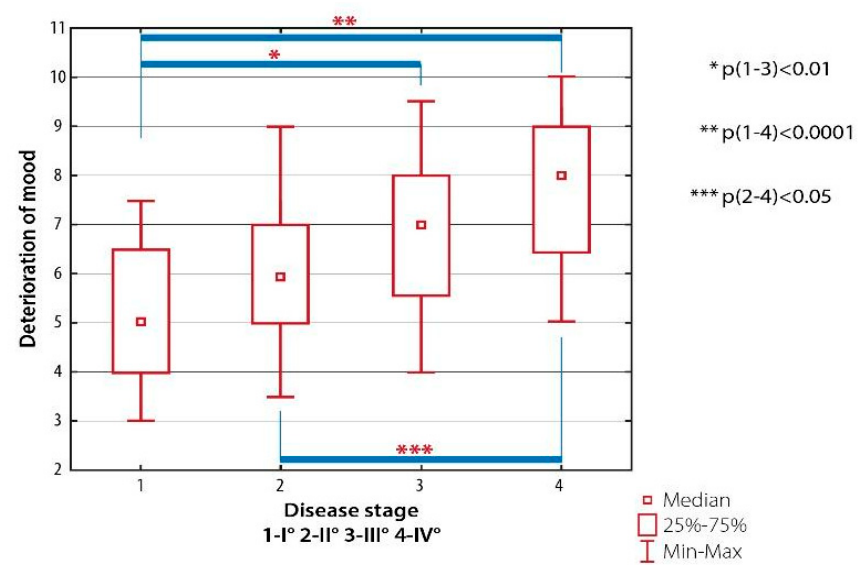
Figure 8. Inter-group differences in emotional well-being scored with AIMS-2: deterioration of mood, depending on the radiological classification of RA (the Steinbrocker classification).